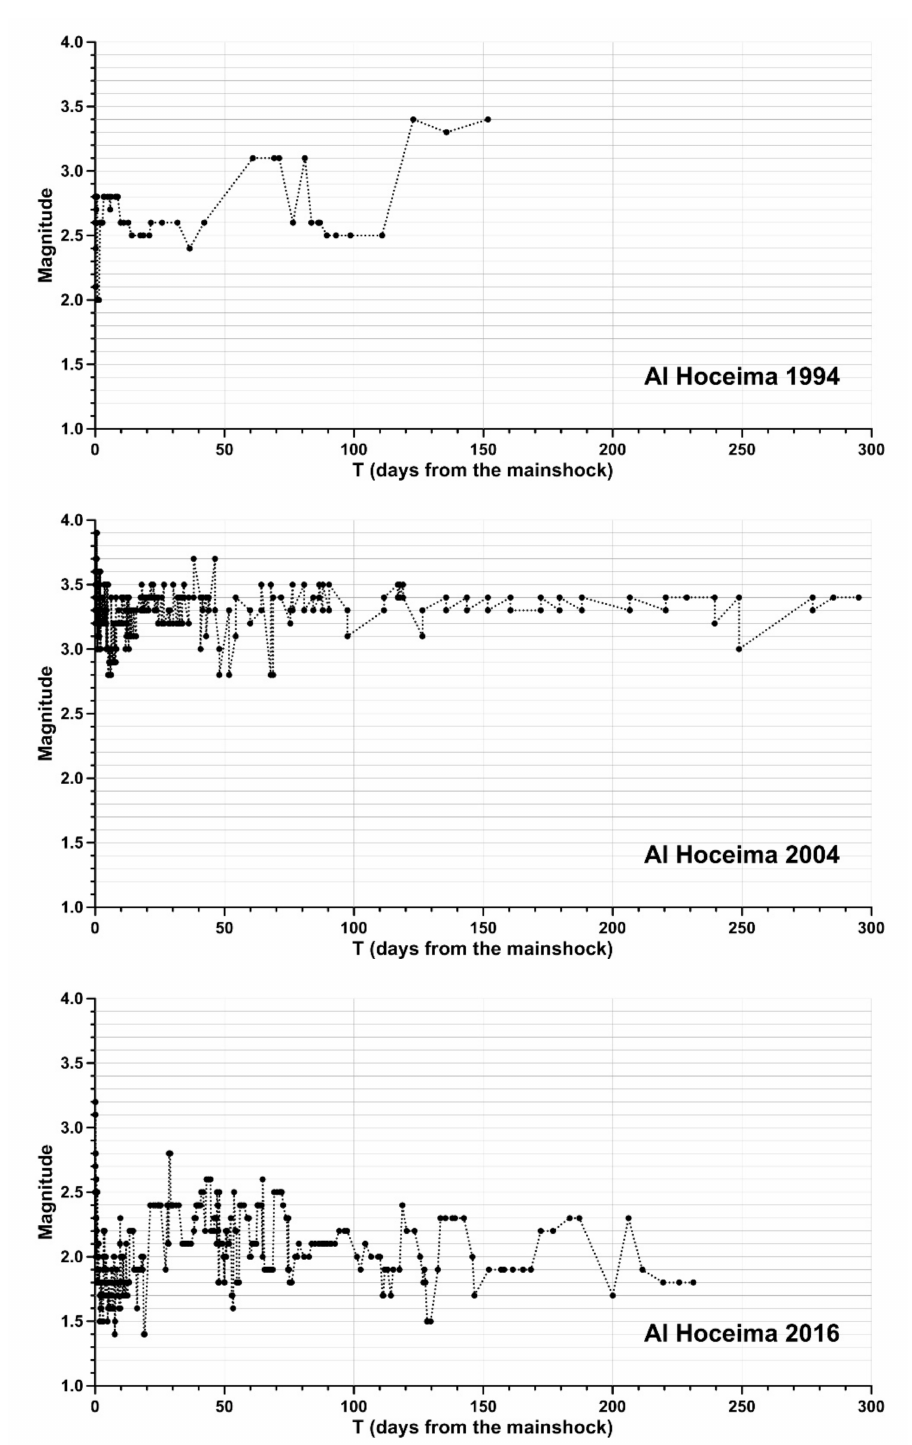
Figure 8. Temporal evolution of the threshold magnitude for the three